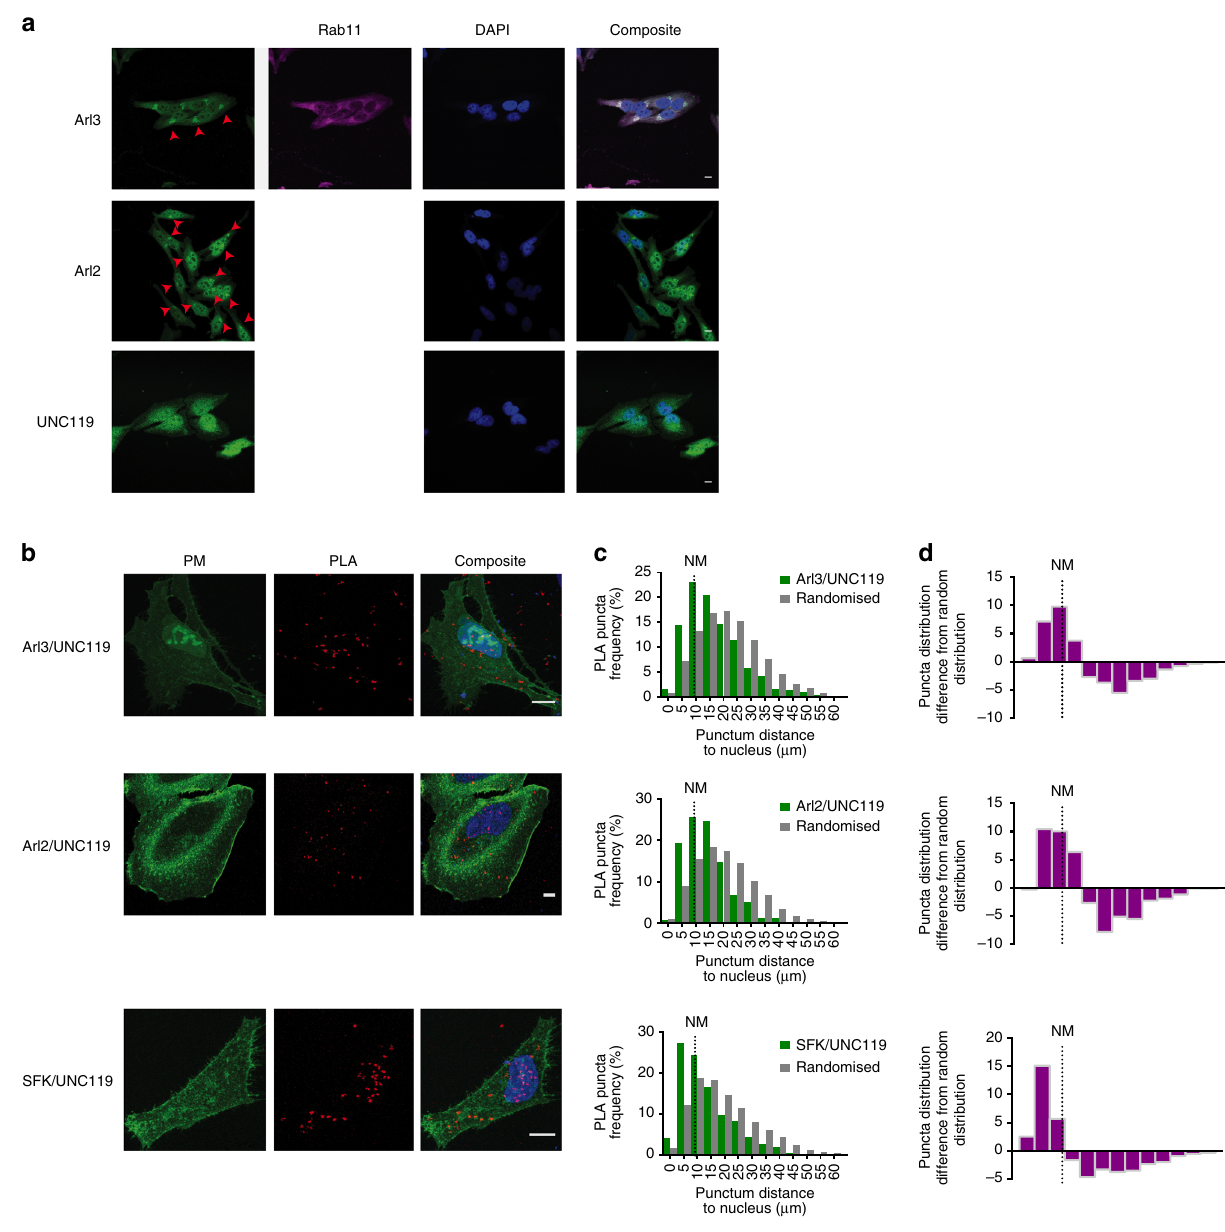
Fig. 4 Arl2/3 interacts with UNC119 in the perinuclear area. a Confocal micrographs of HeLa cells stained with antibodies against Arl2, Arl3 or UNC119. Arl3-stained cells were co-stained with antibodies against Rab11. Nuclei were stained with DAPI (see also Supplementary Fig. 6b). Red arrowheads indicate the enrichment of Arl proteins on perinuclear membrane structures. b Maximum intensity projections of a confocal Z-stack of HeLa cells expressing the PM marker mCit-tk-Ras ( green ), in which in situ PLA ( red ) was performed using Arl2-, Arl3- or SFK-, and UNC119-speci fi c antibodies to reveal the spatial pattern of endogenous interaction between these proteins. Nuclei were stained with DAPI. PLA puncta outside the cell periphery are from cells that were not transfected with mCit-tk-Ras. c Histograms depicting the mean distribution of distances of PLA puncta to the nuclear centre for the interaction pairs indicated ( green pro fi les ). This distribution is interleaved with a mean distance distribution of all pixels within cells to the nuclear centre ( gray pro fi le ). d Histograms depicting the difference between the normalised PLA puncta distribution and the random distance distribution from c ( n = 28 cells for UNC119/Arl2, 26 cells for UNC119/Arl3 and 47 for UNC119/SFK, data from at least two independent experiments per condition). Scale bars , 10 μ